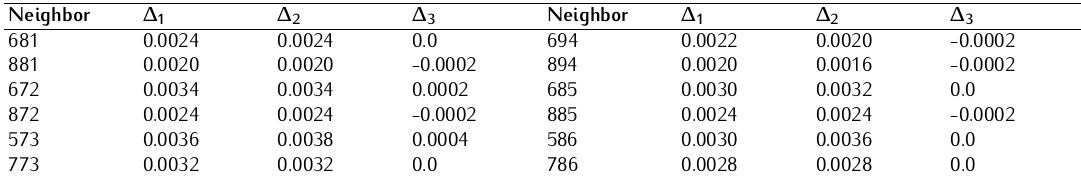
117 neighbors of an OSIA within the Cu host lattice.